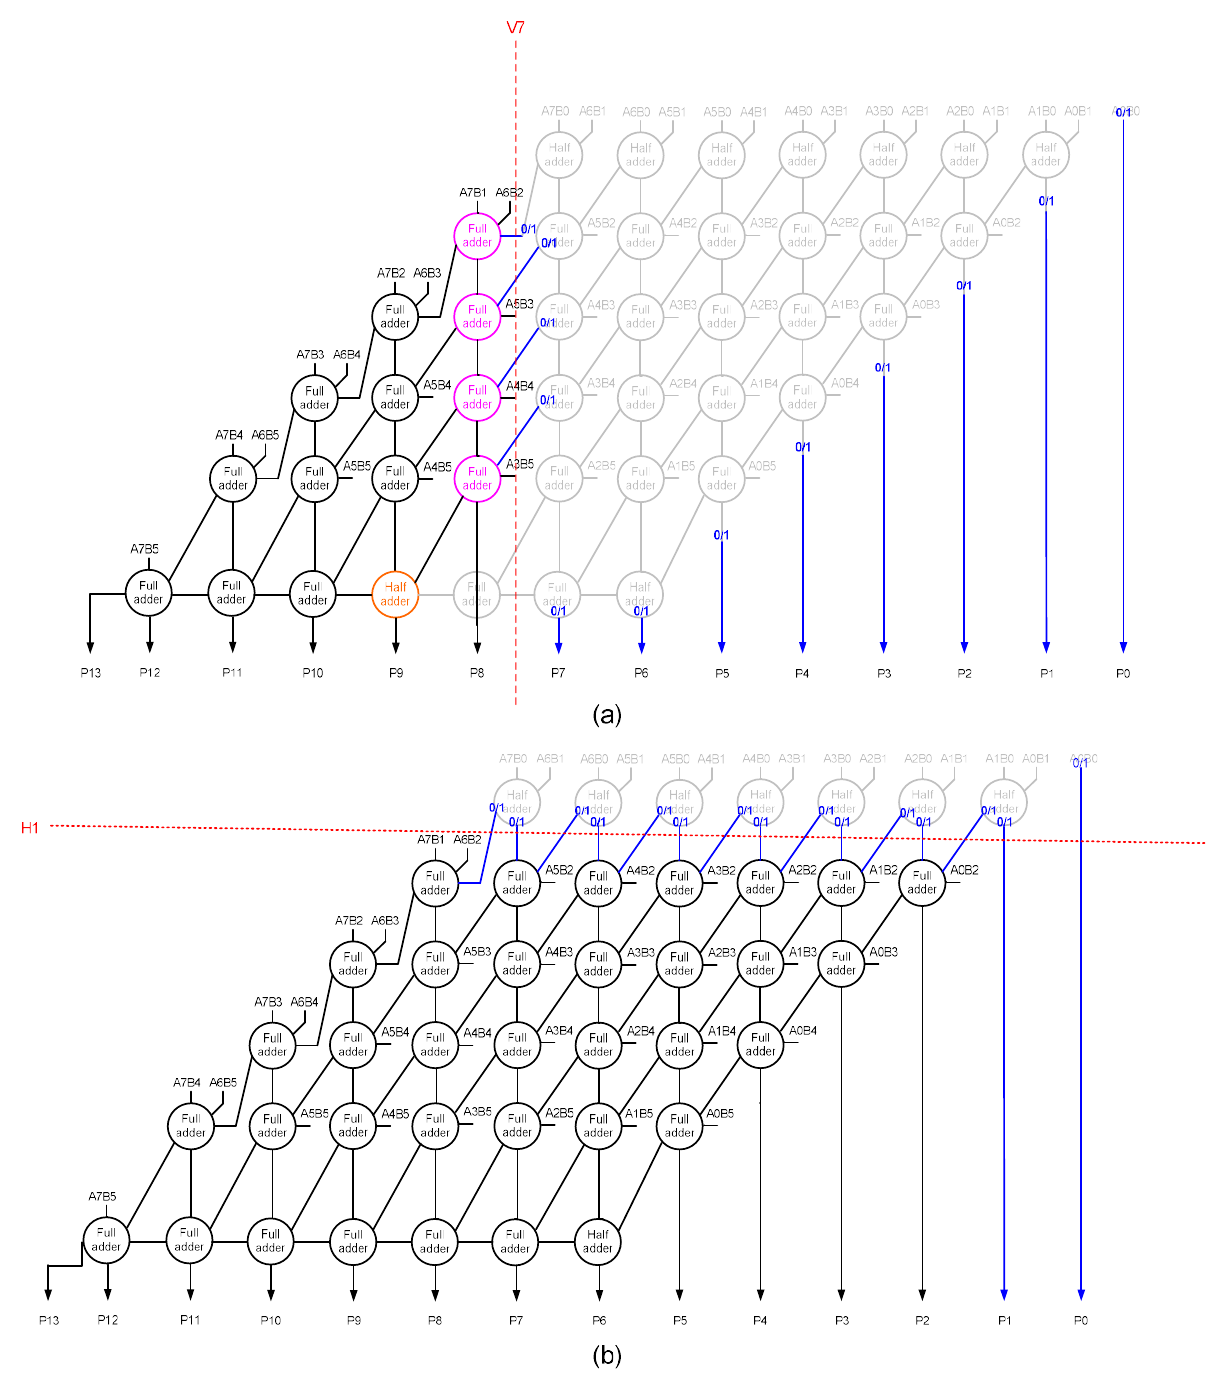
Figure 3. Illustrating the effect of example vertical and horizontal cuts on an accurate array multiplier resulting in approximate array multipliers. (a) Vertical cut V7; (b) horizontal cut H1. The circuit portions eliminated are shown in light gray.